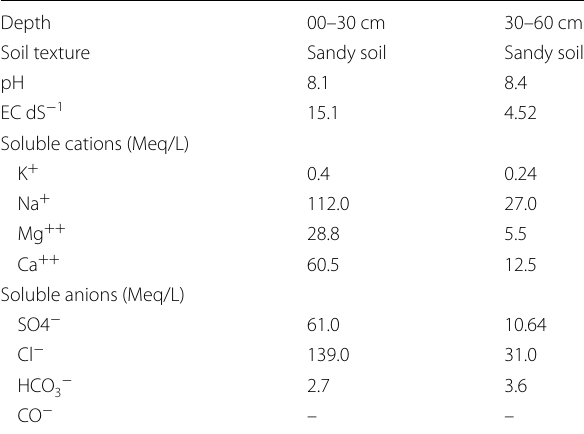
Table 2 Chemical and mechanical analysis of the